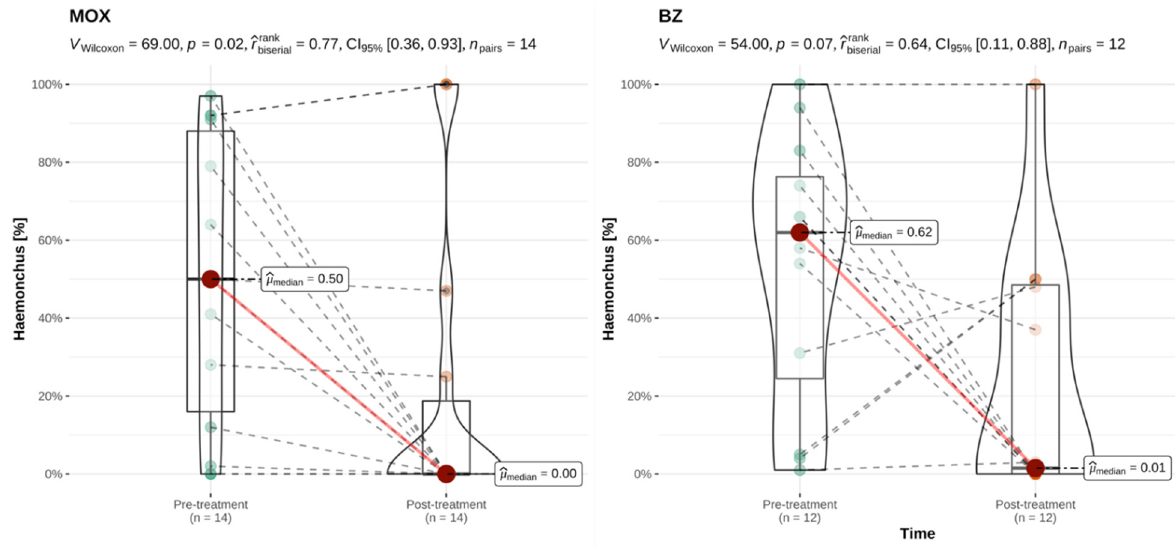
Figure 5. Paired comparison of the pre- and post-treatment percentage of H. contortus eggs for treatments performed in goats, by anthelmintic category. This analysis included all caprine treatments irrespective of their classification as successful or unsuccessful. MOX = moxidectin; BZ = benzimidazoles; n = number of flocks treated per category with available paired results. r rankbiserial = effect size with CI 95% = 95% confidence interval; n pairs = number of paired results . Interpretation of r rankbiserial : <0.05: tiny; ≥ 0.05 and < 0.1: very small; ≥ 0.1 and <0.2: small; ≥ 0.2 and <0.3: medium; ≥ 0.3 and <0.4: